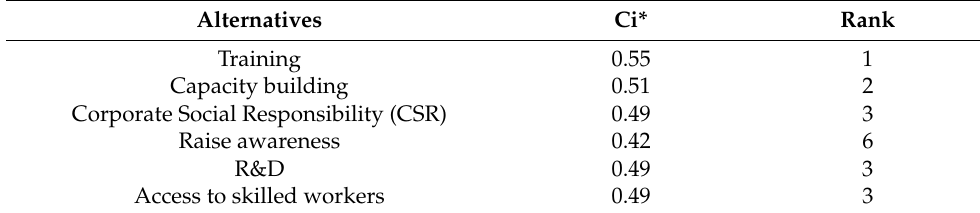
Table 4. Ranking of alternatives in human factor criteria. Alternatives Ci* Rank Training 0.55